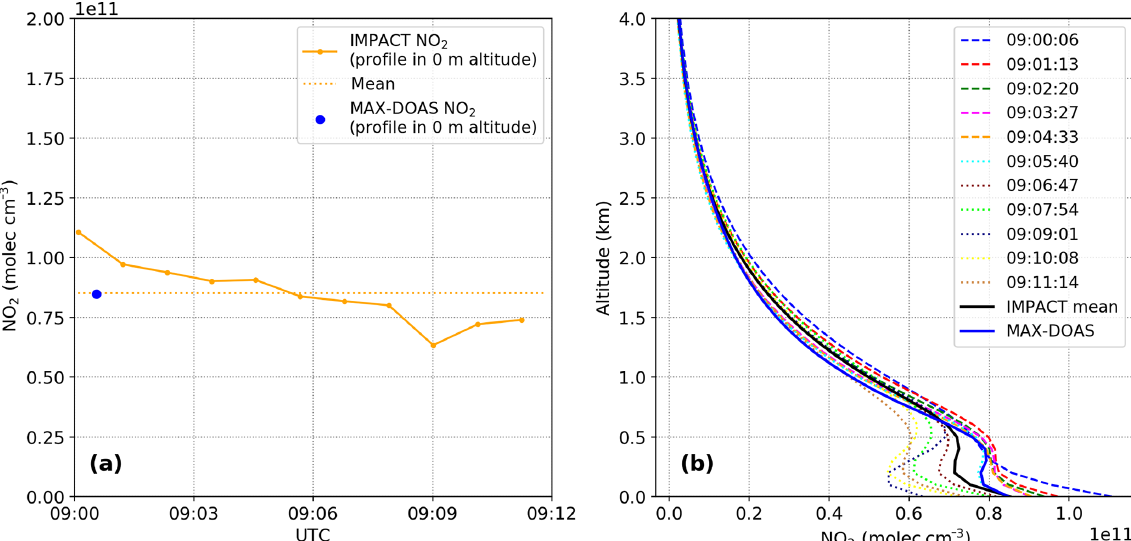
Figure 13. NO 2 surface concentrations (a) and profiles (b) retrieved from IMPACT’s high-repetition measurements in the common azimuth direction of 287 ◦ during the acquisition of one MAX-DOAS vertical scan at 23 September 2016. Corresponding NO 2 DSCDs used as input for the profile retrieval are shown in Fig.